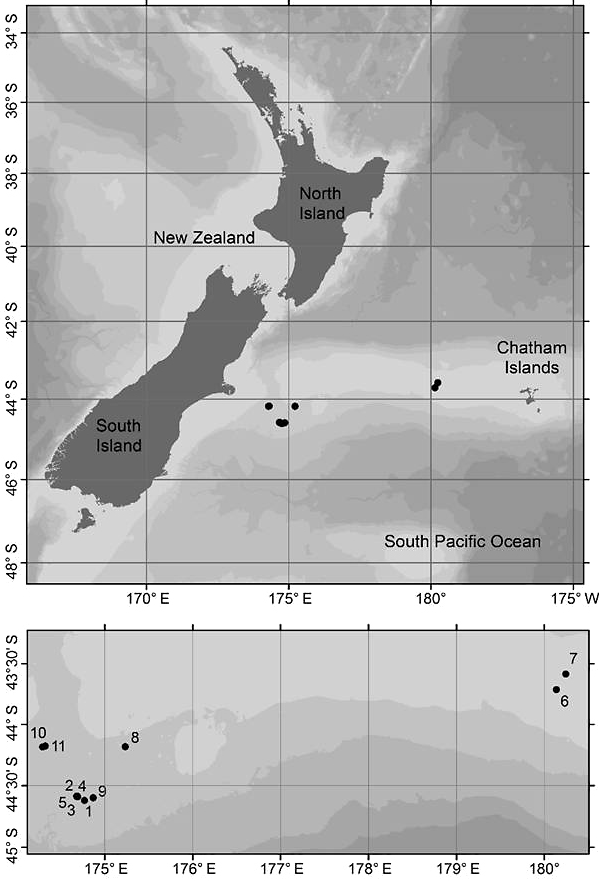
Figure 2. A map of New Zealand waters showing the locations of the 11 SSM sampling stations (solid dots). Station numbers are shown in the expanded Chatham Rise region in the lower